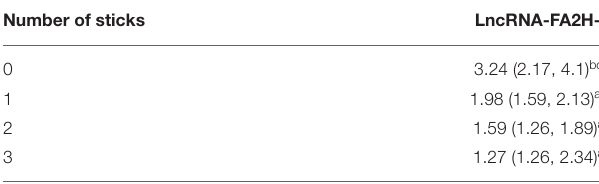
TABLE 6 | The expression levels of LncRNA-FA2H-2 in lesion branch number subgroups.